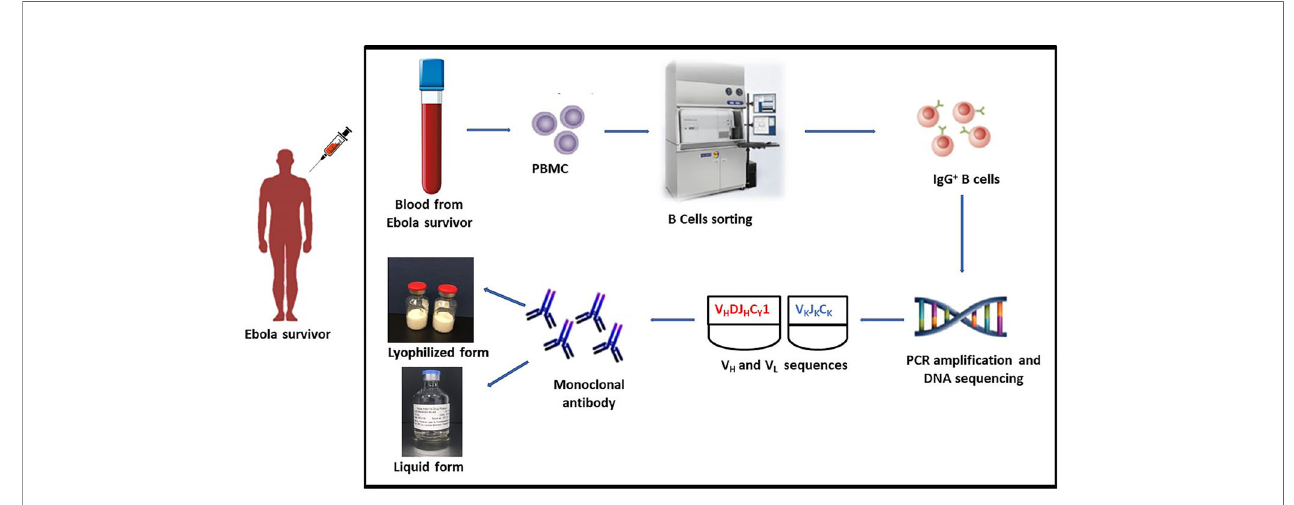
FIGURE 1 | mAb114 development technique. Blood collected from EVD survivor. PBMC isolation followed by identi fi cation of the mAb114 memory B cell clone. Heavy and light chain sequences obtained by PCR ampli fi cation and DNA sequencing. Heavy and light chain sequences cloned into a standard expression vector. Expression vector used to generate a stably transfected CHO DG44 cell line for use in manufacture.